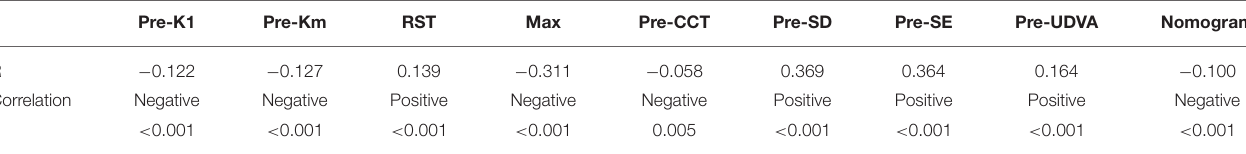
TABLE 4 | The result of the correlation analysis.